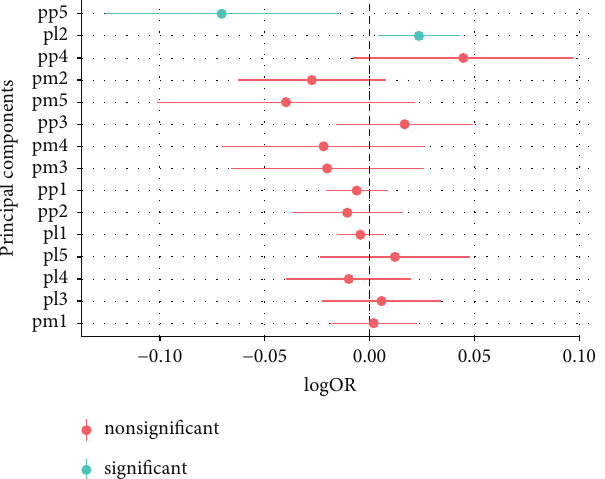
Figure 3: Main loadings for PL2, when comparing MHO with